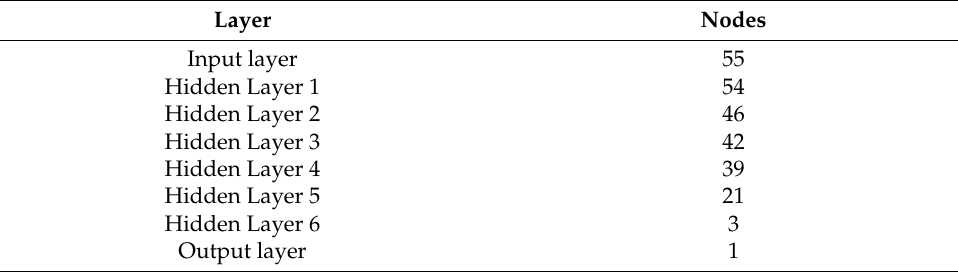
Table 3. Number of nodes for each layer including BBE data